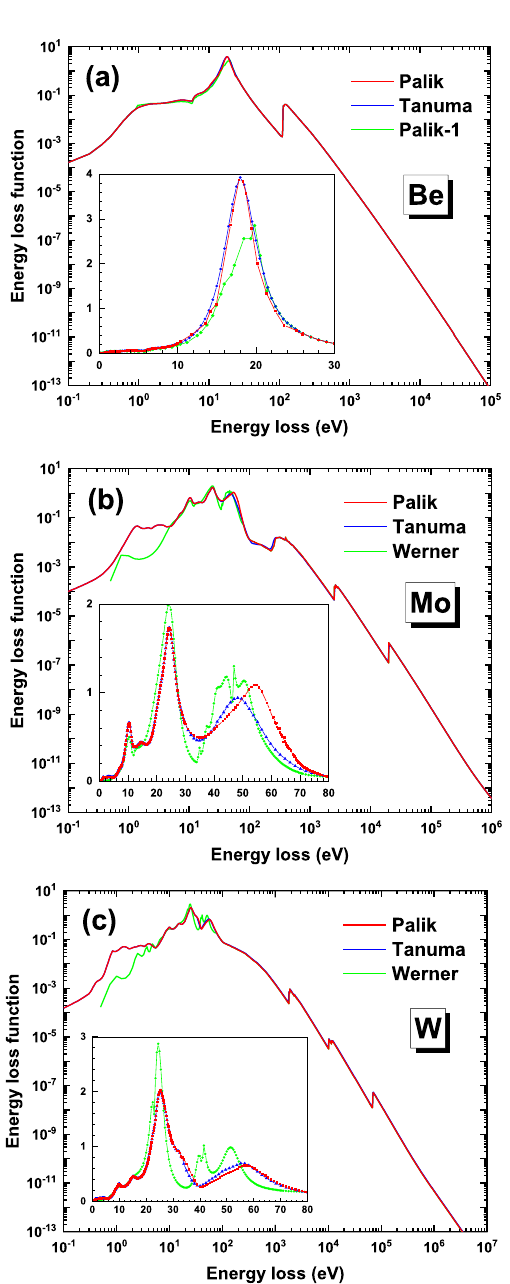
Figure 1. The energy loss functions of ( a ) beryllium, ( b ) molybdenum and ( c ) tungsten, where the data properties are described in Tables 1 and